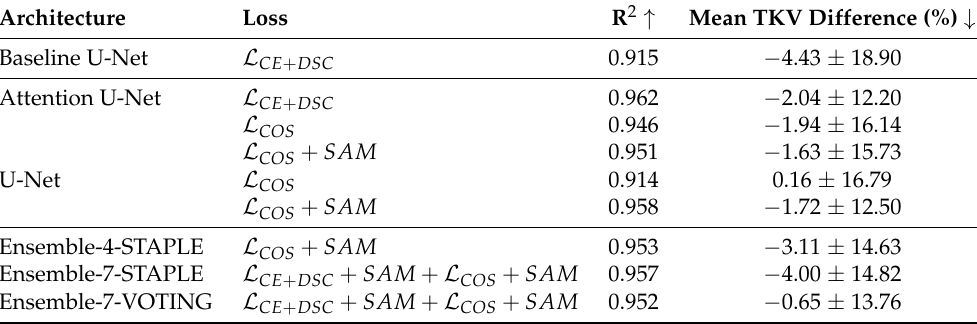
Table 3. The R 2 and mean TKV difference (%) of selected network configurations (post-processed, patch size: 128) for ground truth TKV v/s predicted TKV (ml). The baseline linear fit has R 2 value of 0.915. The U-Net with L COS and L COS + SAM have R 2 values of 0.914 and 0.958, respectively. The Attention U-Net with L COS and L COS + SAM have R 2 values of 0.946 and 0.951, respectively. Among the Ensembles, the highest R 2 is 0.957. Meanwhile, the Attention U-Net with L CE + DSC achieves the overall highest R 2 value of